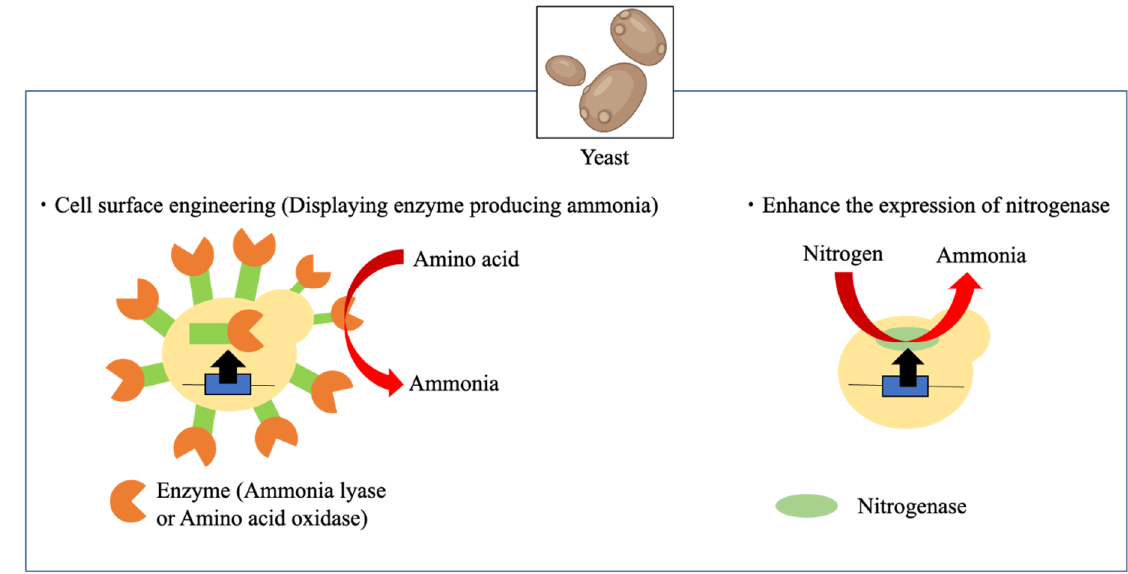
Figure 4. Ammonia production using engineered yeast (created with Biorender.com).